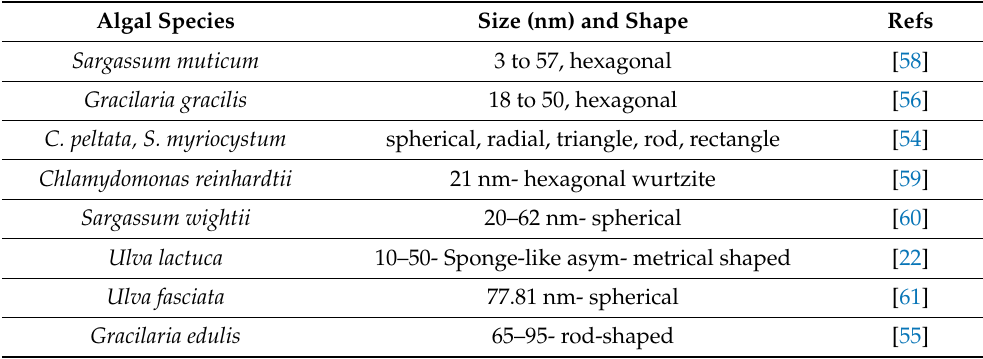
Table 1. Synthesis of zinc oxide nanoparticles using marine algae. Algal Species Size (nm) and